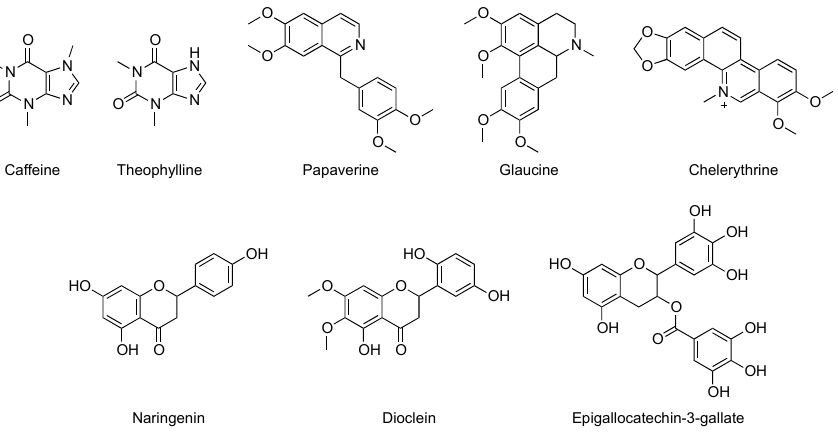
Figure 1. Chemical structures of some of the known natural phosphodiesterase (PDE) inhibitors.